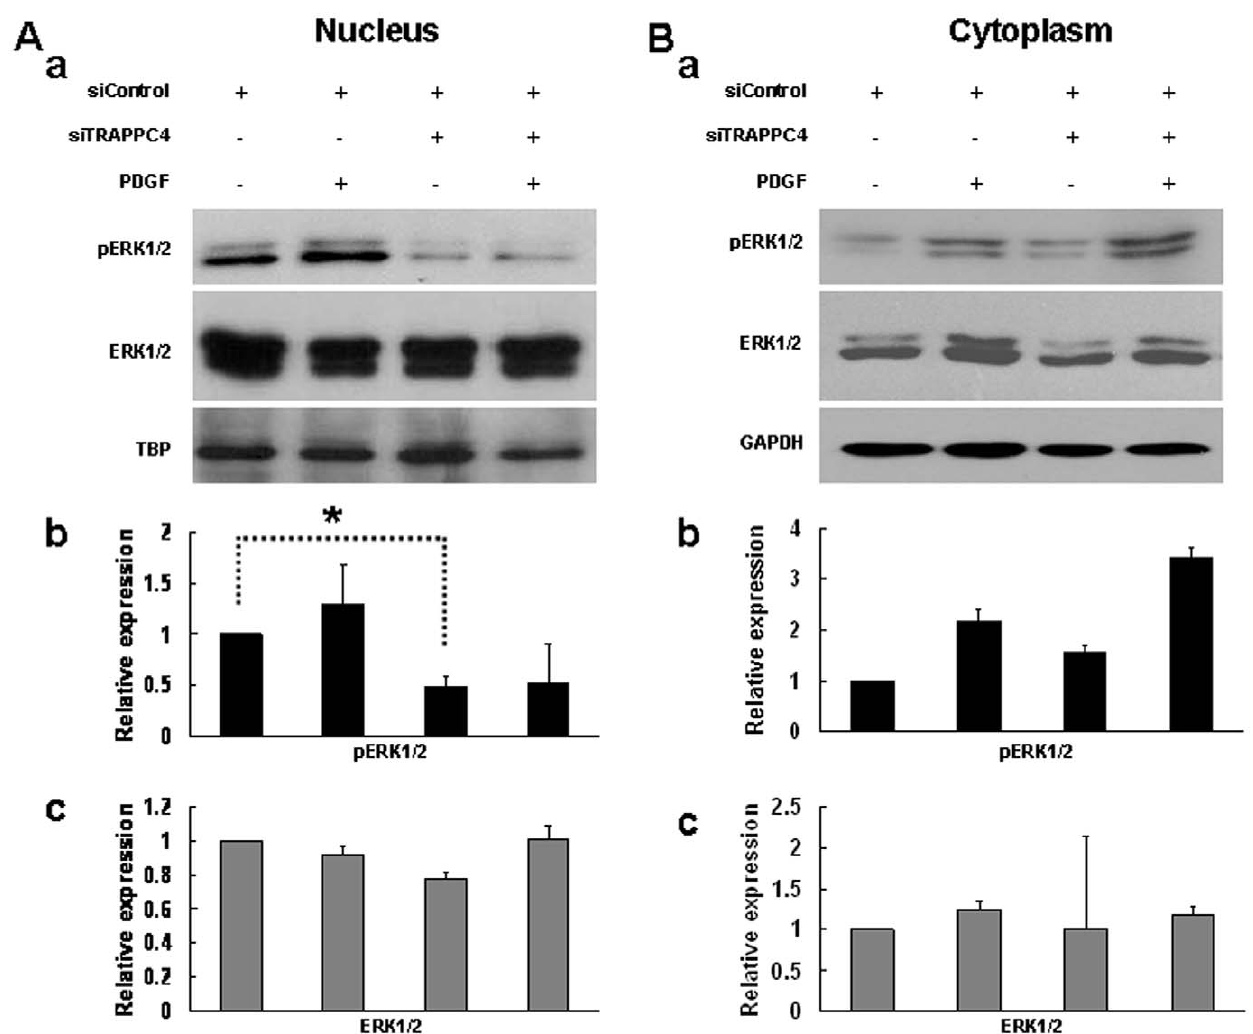
Figure 3. Knockdown of TRAPPC4 decreased actived ERK1/2 level in nucleus on SW1116 cell line. SW1116 cells were transfected with TRAPPC4 siRNA (siTRAPPC4) to knockdown TRAPPC4 expression or with Negtive Control siRNA (siControl) as control; Also cells were treated with PDGF to activate ERK-MAPK pathway, or with its solvent (PBS + 0.1% BSA) as control. Cytoplasm and nuclear extracts were prepared as described in experimental procedures, and equal amounts of protein were analyzed by Western blot analysis using antibodies against phospho-ERK1/2 (pERK1/2), or ERK1/2, or TRAPPC4. The density of the Western blot bands were normalized to the amount of GAPDH protein for cytoplasma protein or TBP for nuclear protein. The data shown are representative of three replicate experiments. *, p ,